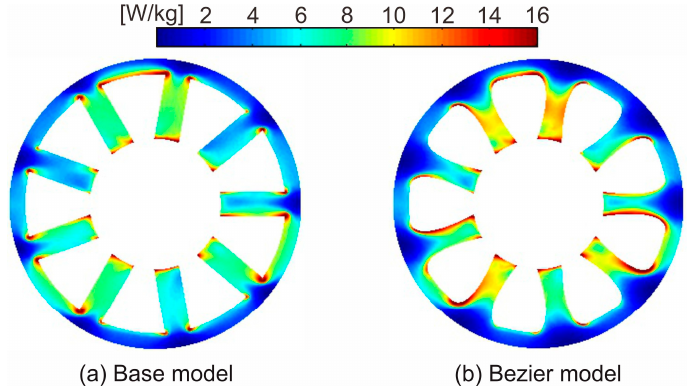
Figure 6. Core loss distribution of ( a ) the base model and ( b ) Bezier model.